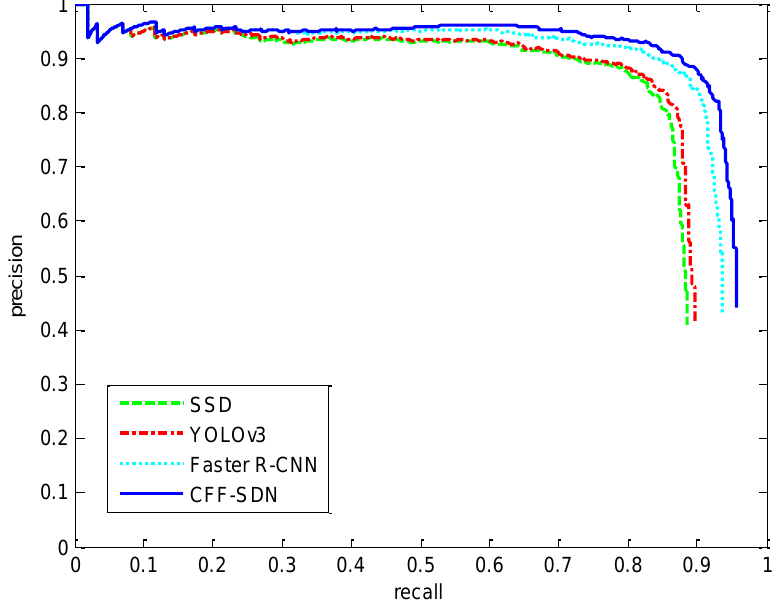
Figure 17. Precision–recall curves of Faster R-CNN, SSD, YOLOv3 and CFF-SDN.